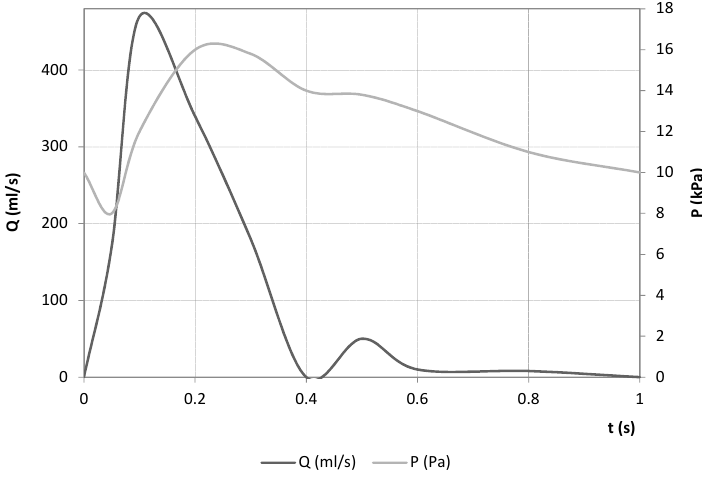
Figure 10. Boundary conditions used in both models.